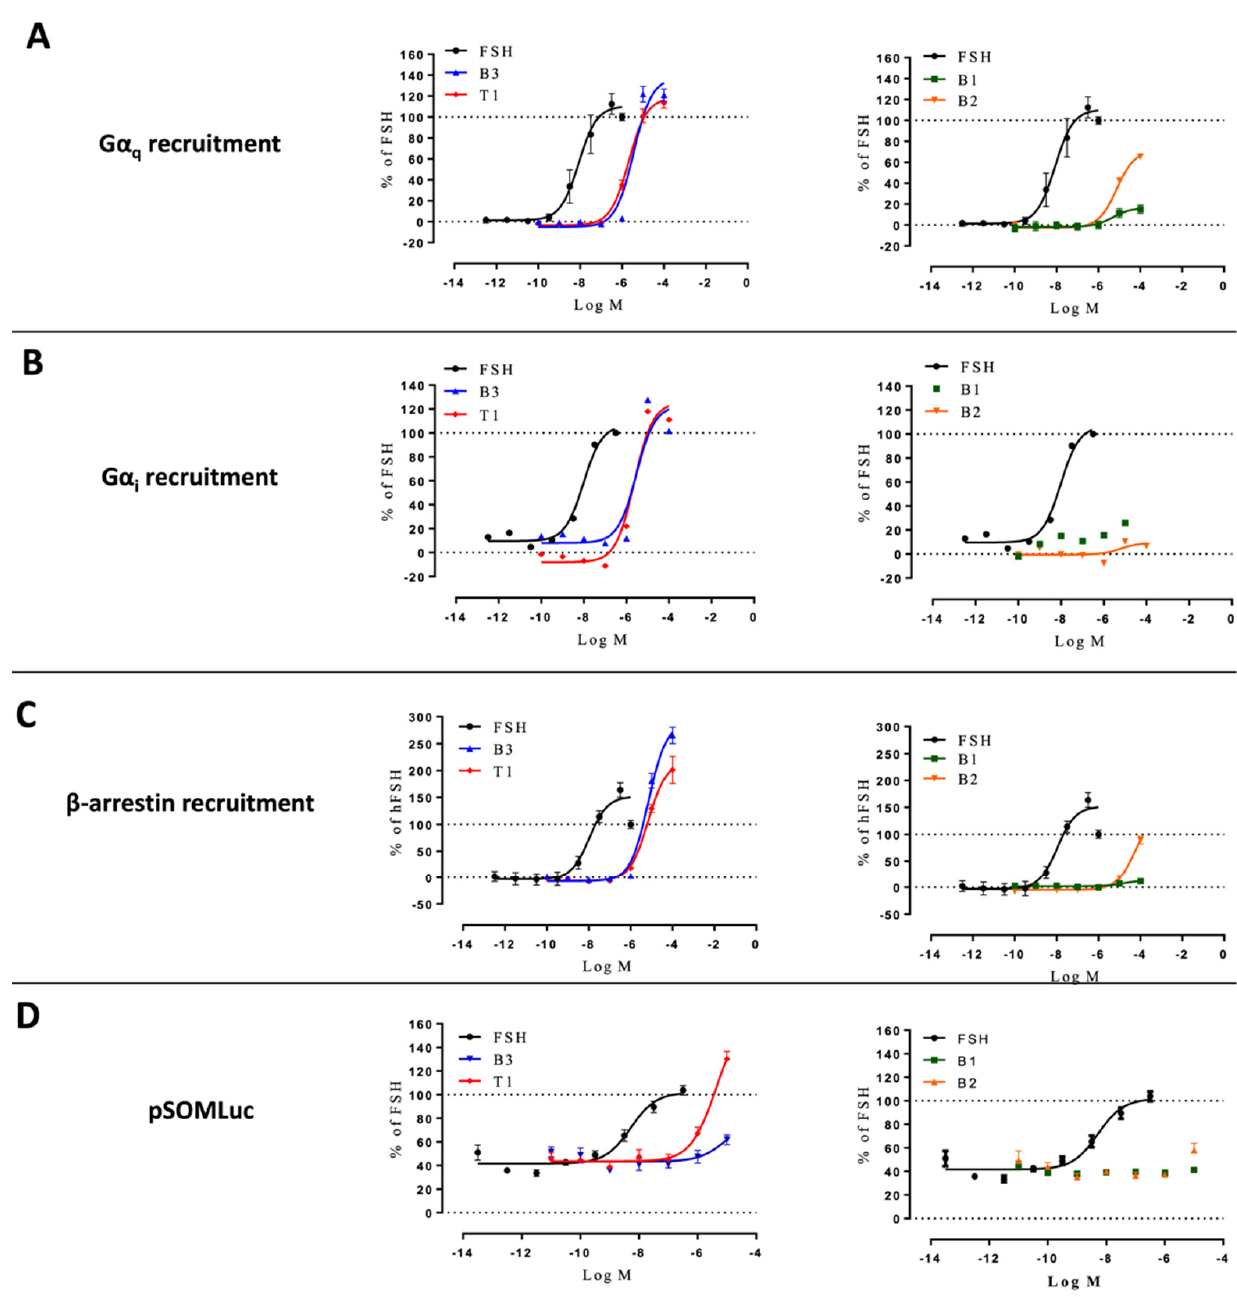
Figure 6. Profiling of LMW ligands vs. FSH in HEK293/ ∆ G α s cells. ( A ) G α q recruitment, ( B ) G α i recruitment, ( C ) β -arrestin 2 recruitment, and ( D ) CRE reporter gene induction were measured. Transfected HEK293/ ∆ G α s cells were challenged with increasing doses of FSH (10 − 12.5 to 10 − 6.5 M) or LMW ligands (10 − 10 to 10 − 4 M). Signals were monitored for 30 min. Concentration/activity curves were calculated by considering the area under the curves. Values were normalized considering FSH maximal response as 100%, plotted, and fitted using non-linear regression. Data are represented as mean ± SEM from at least six independent experiments.